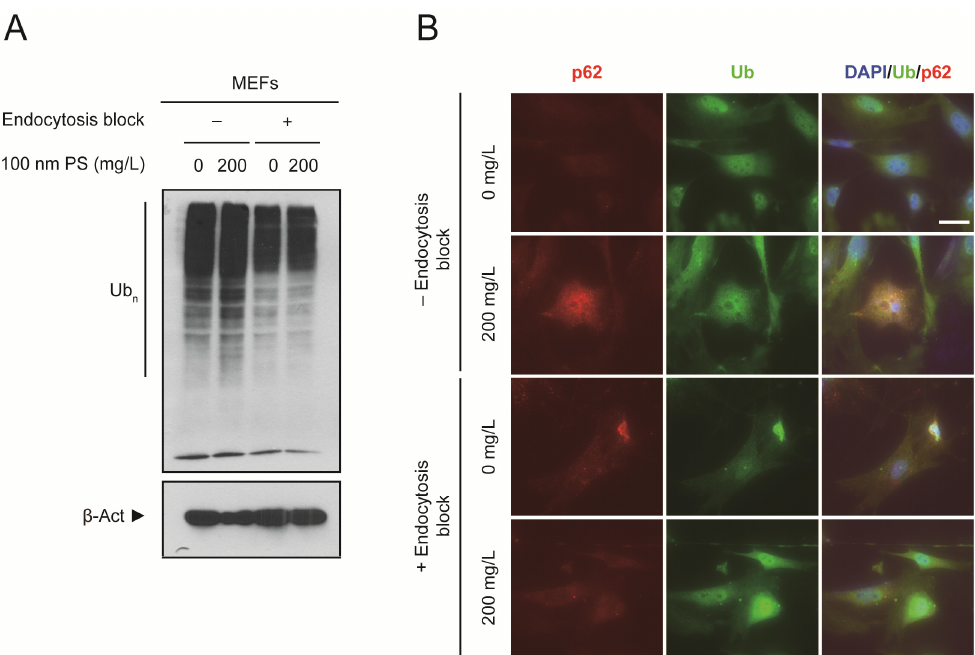
Figure 3. Interference with normal autophagic function in MEFs in the presence of PS nanoplastics. ( A ) Immunoblot detection of ubiquitin conjugates (Ub n ) in MEFs treated with PS nanoplastics at the indicated concentration for 1 day with or without sodium azide pretreatment to block endocytosis. β -Actin ( β -Act) was used as a loading control. ( B ) MEFs were treated with 100 nm PS nanoplastics at the indicated concentration for 1 day with or without sodium azide pretreatment to block endocytosis. Cells were subjected to immunofluorescence analysis using anti-p62 and anti-Ub (FK2) antibodies, and DNA was visualized with DAPI. Representative immunoblots or images of cells are shown. Scale bar, 50 μ m.